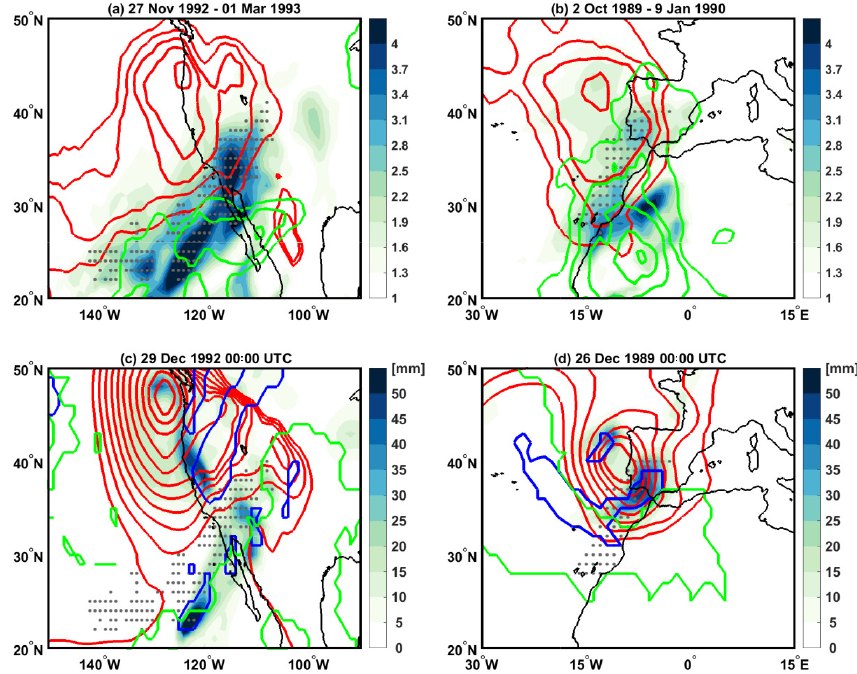
Figure 8. (a) Ratio of accumulated precipitation during the period 27 November 1992 to 1 March 1993 with respect to climatological values for the same time period (in color) for an extreme wet season patch affecting the US west coast (dotted area). Red (green) contours show areas with positive anomalies of cyclone (TME) occurrences with respect to climatology. Contours start from 5% and have a 5% interval. (b) As (a) but for the period 2 October 1989 to 9 January 1990 for an extreme wet season patch affecting the Iberian Peninsula (dotted area). (c) 24h accumulation of precipitation from 12:00UTC on 28 December to 12:00UTC on 29 December 1992 (in color). Red contours show sea level pressure at 00:00UTC on 29 December 1992 (starting from 1015hPa and with a step of − 3hPa). Green contours show areas with TMEs and blue contours show areas with WCB ascent. (d) As in (c) but at 00:00UTC on 26 December